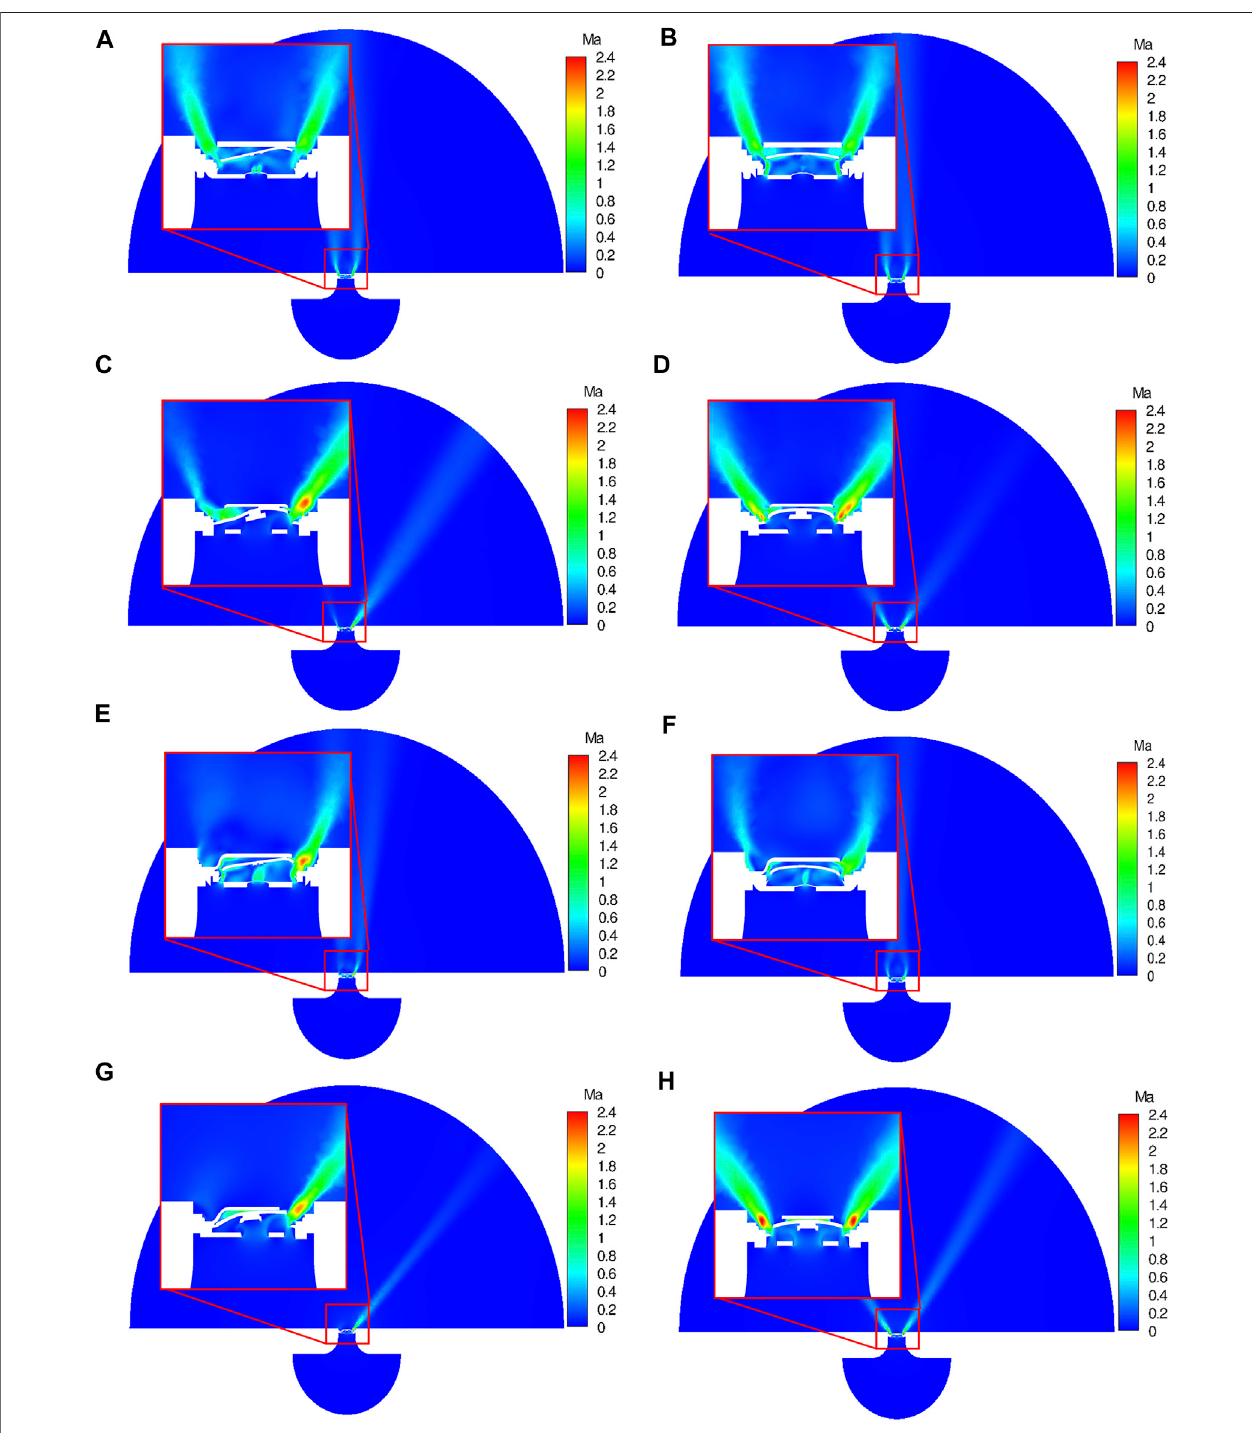
FIGURE6| RANSsimulatedMachnumberdistributionat P 1 /P 2 (cid:1) 7,inthex-normal (left) andz-normal (right) cross-sectionalplanesforeachLIBcap:MTI (A) and (B) , LG MJ1 (C) and (D) , K2 (E) and (F) , and LG M36 (G) and (H) .